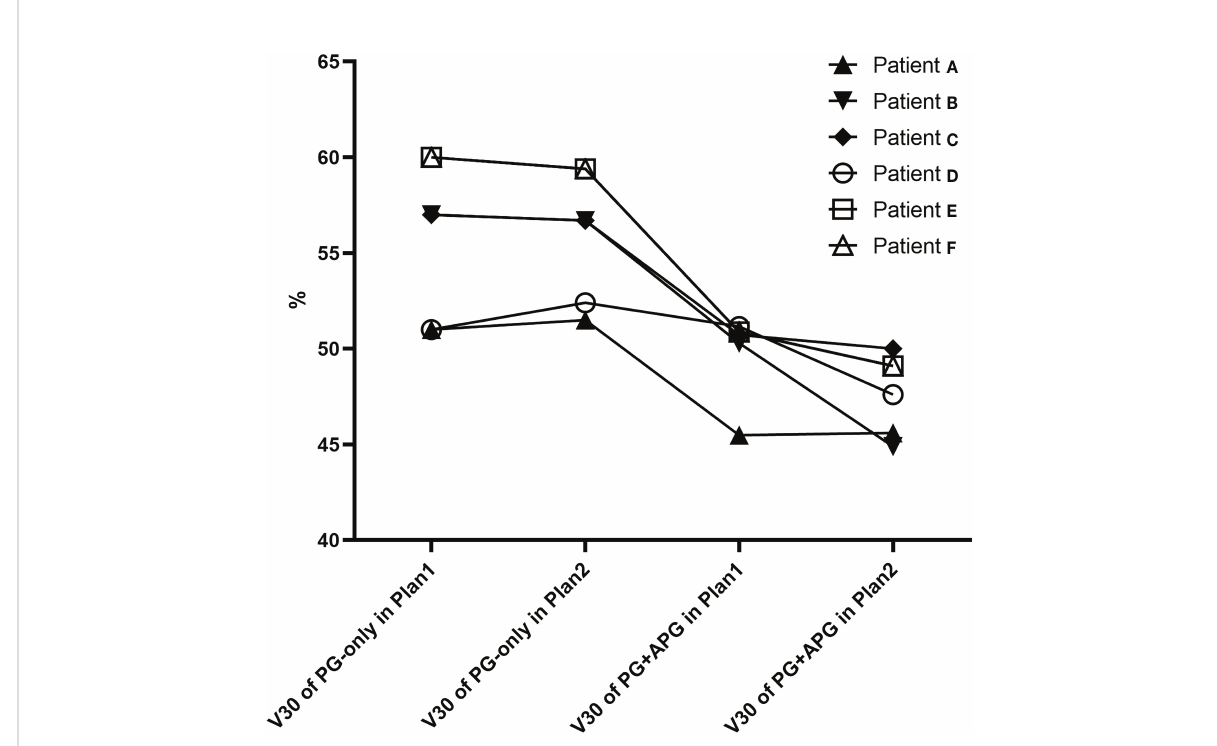
the development of clinically signi fi cant xerostomia are shown in Table 3. Patients who underwent induction chemotherapy and concurrent chemoradiotherapy (InC+CRRT) were associated with signi fi cantly higher rates of grade 2 – 3 xerostomia compared to those who underwent CCRT alone (p < 0.05).